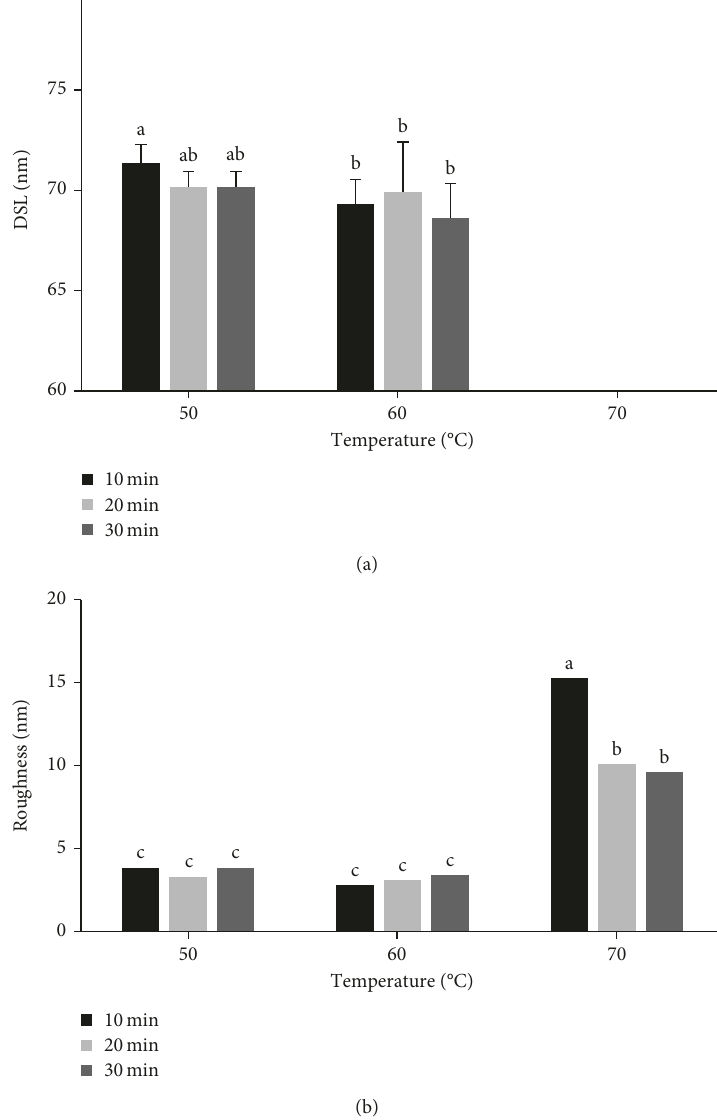
Figure 7: DSL (a) and roughness (b) of collagen fibrils under different water bath temperatures and times. a, b, and c values in the row and column; entries with the same superscript are not significantly different ( p ≥ 0 .